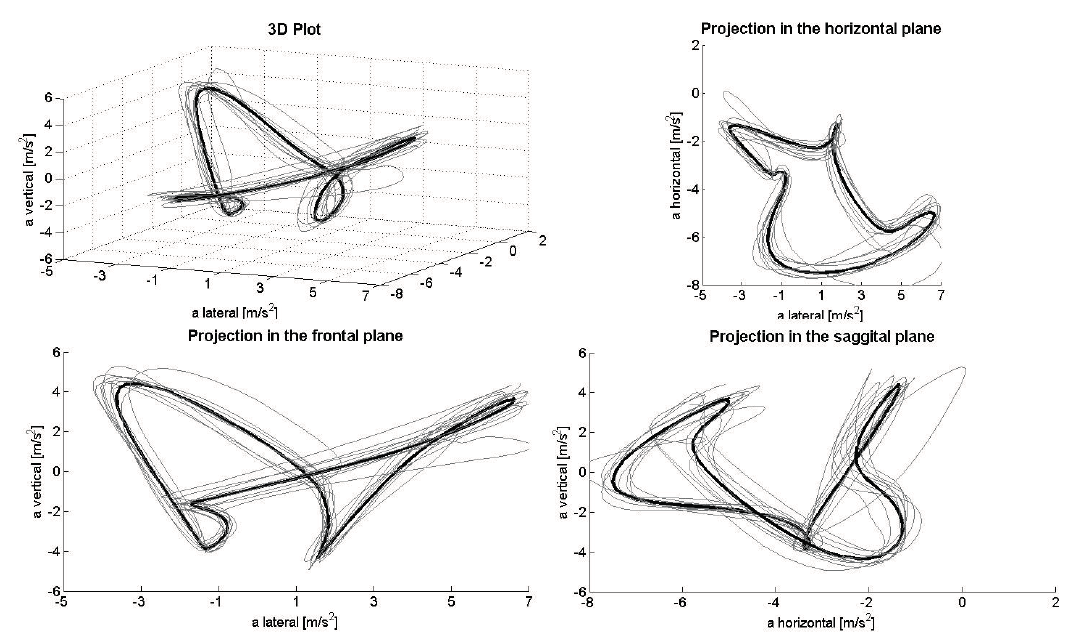
Figure 5. Acceleration data during G4R in the total space ( upper left ) and frontal ( lower left ), horizontal ( upper right ) and sagittal planes ( lower right